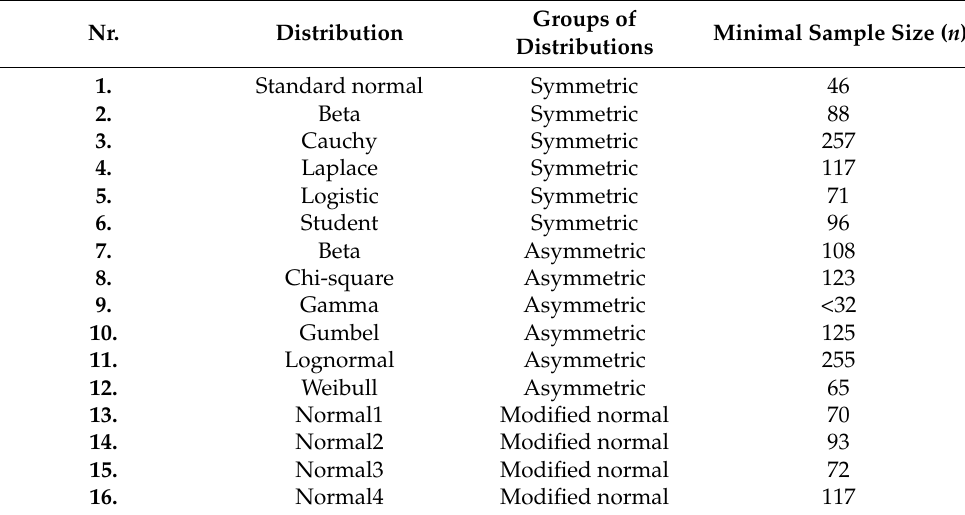
Table 4. The minimal sample size at which the N-metric test is most